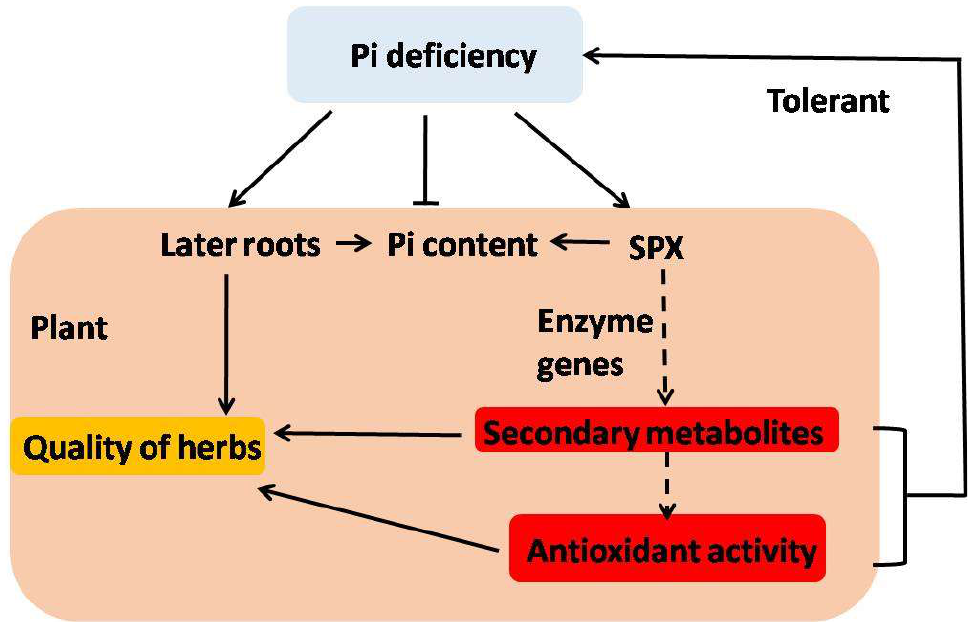
Figure 8. The model of interaction of plants with Pi deficiency based on secondary metabolism and antioxidant defenses. Uncertain steps are represented by dotted lines.